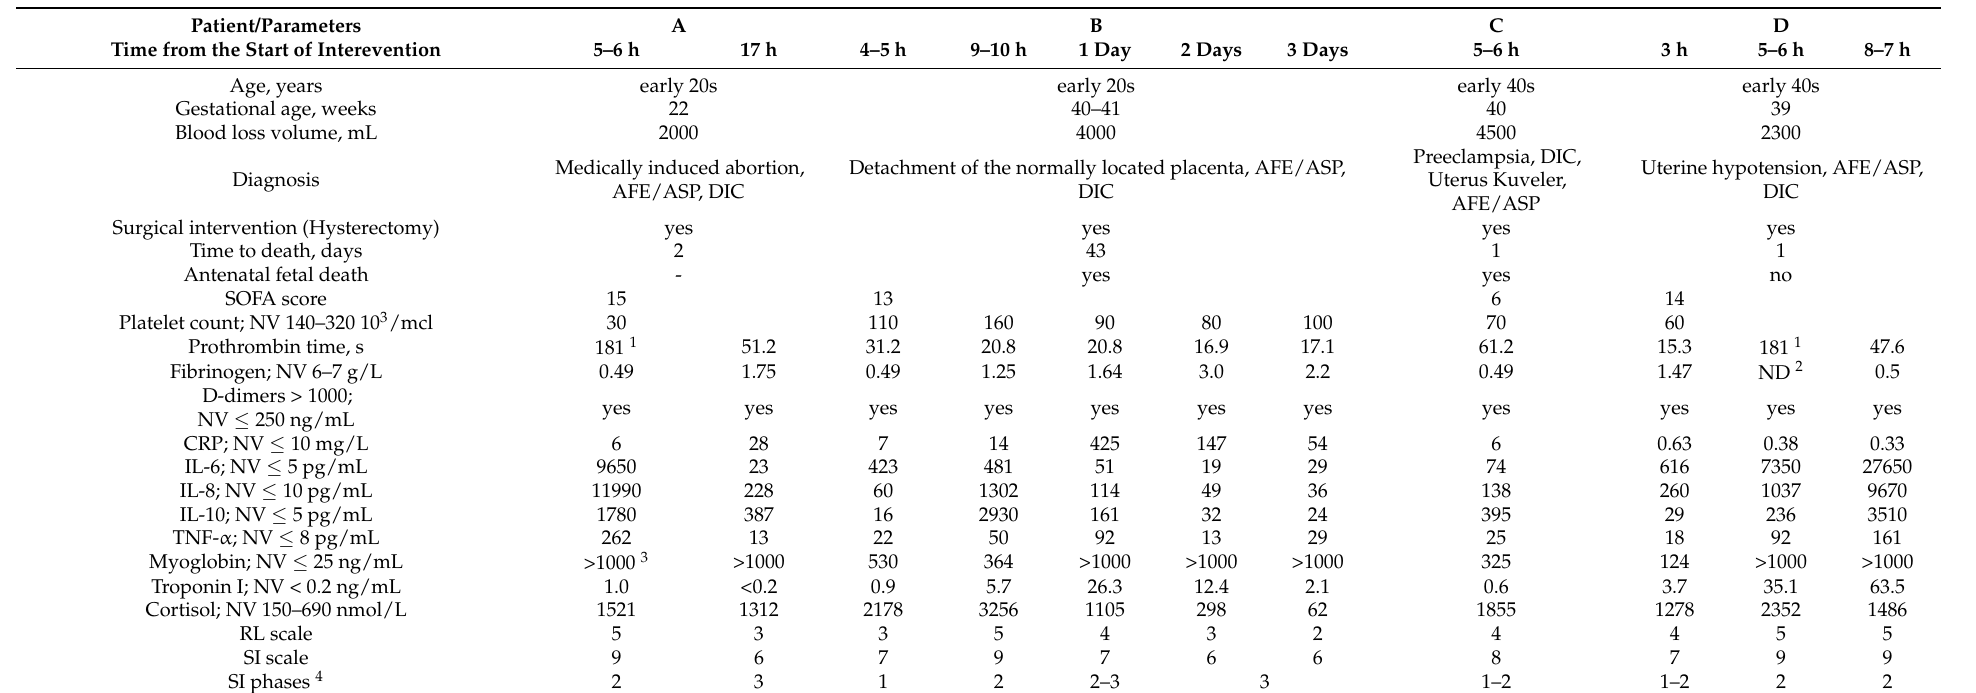
Table 1. Clinical and laboratory parameters of the patients and phases of systemic